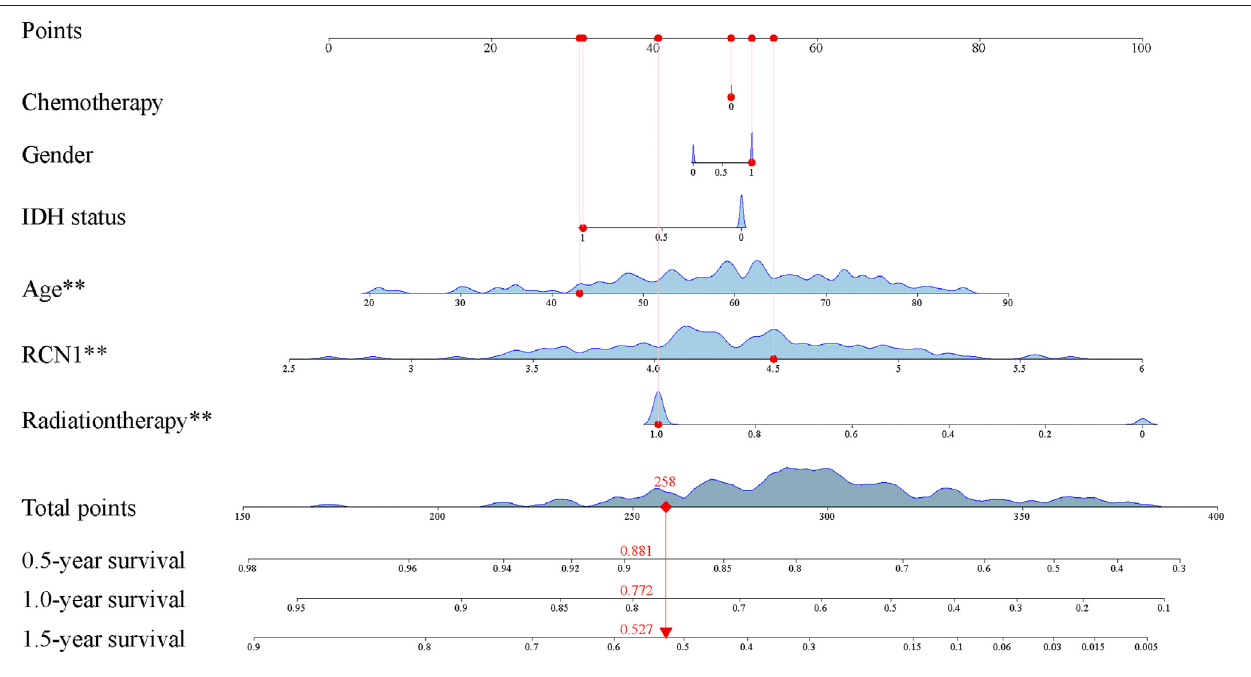
FIGURE 5 | Construction of prognostic